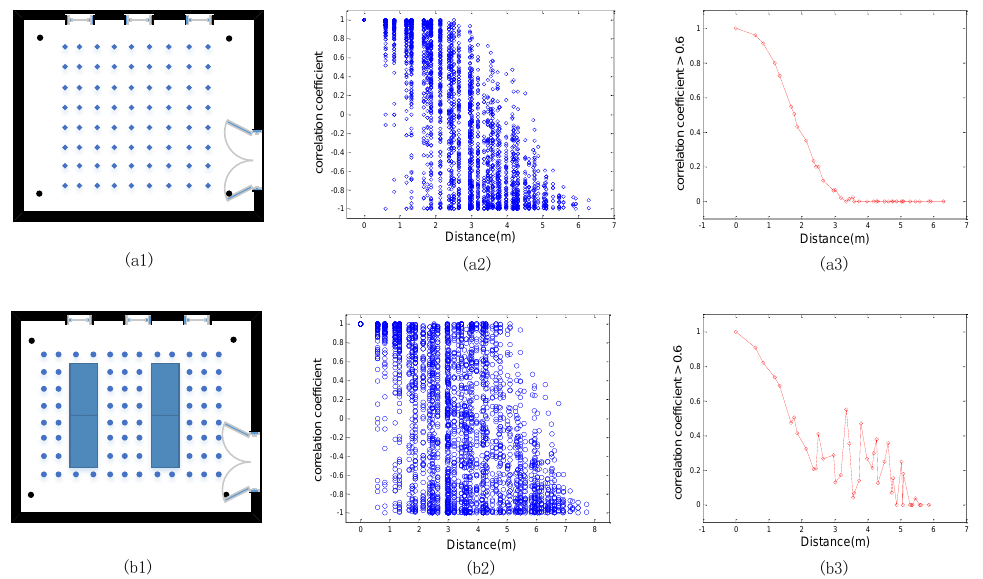
Figure 2. The correlation coefficient value between RPs in two typical indoor positioning scenes: ( a1 ) setting of experimental environment for simple indoor positioning scene; ( a2 ) relationship be- tween correlation coefficient and distance of RPs in simple indoor positioning scene; ( a3 ) the ratio of the correlation value for RPs beyond 0.6 in simple indoor positioning scene; ( b1 ) setting of exper- imental environment for complex indoor positioning scene; ( b2 ) relationship between correlation coefficient and distance of RPs in complex indoor positioning scene; ( b3 ) the ratio of the correlation value for RPs beyond 0.6 in complex indoor positioning